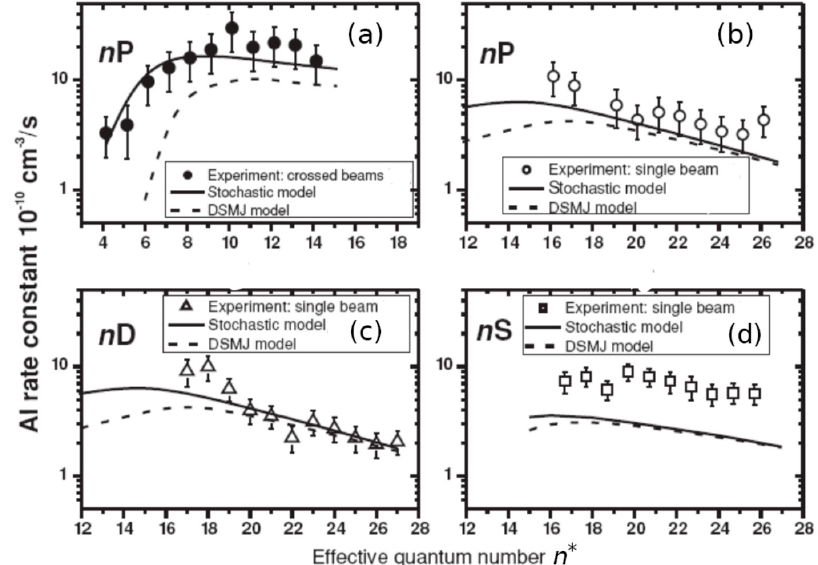
Figure 11. Values of rate constants of associative ionization for collisions in a single beam (frames ( b – d )) and in two orthogonal crossed beams (frames ( a )) of sodium atoms excited in n S, nP, and n D Rydberg states [66,67].